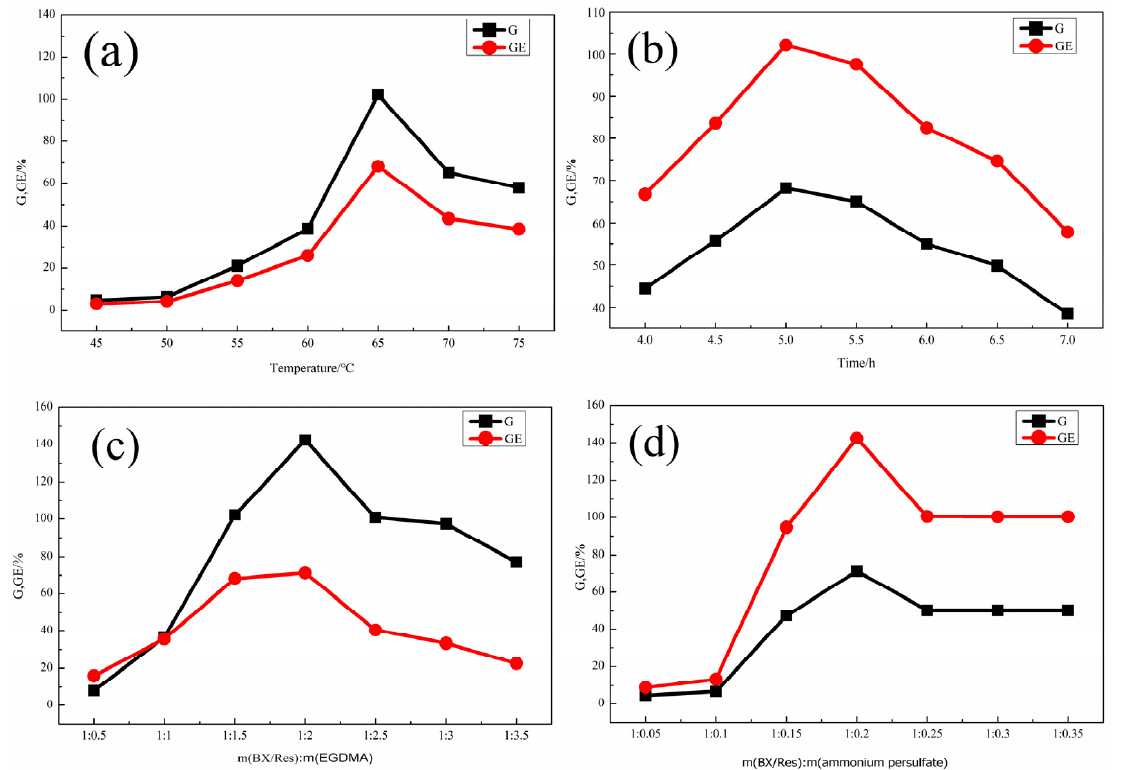
Figure 2. ( a ) The effect of reaction temperature on G and GE . ( b ) The effect of reaction time on G and GE. ( c ) The effect of m(BX/Res):m(EGDMA) on G and GE . ( d ) The effect of the mass of ammonium persulfate on G and GE .